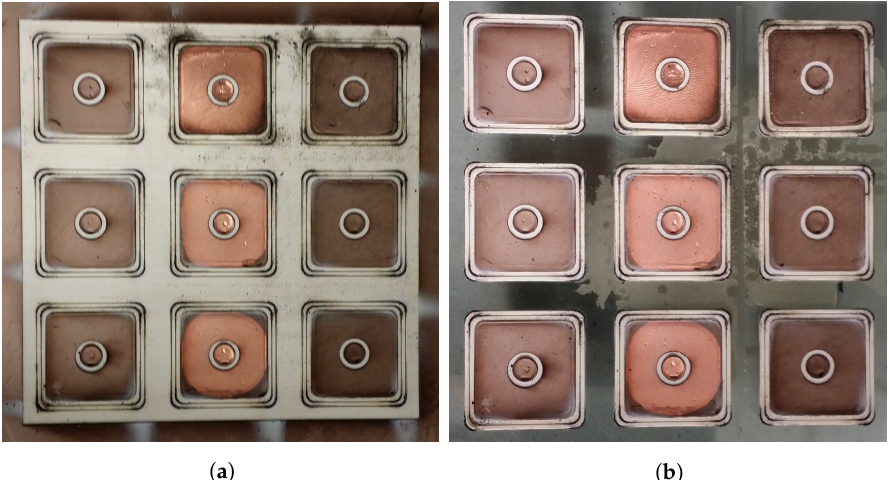
Figure 7. Laser-structured sensors (3 × 3) inside the multi-layer silicone composite film on a glass substrate ( a ) and after removal of the overhanging silicone composite film ( b ). Galvanic metallization took place only for the middle three sensors.